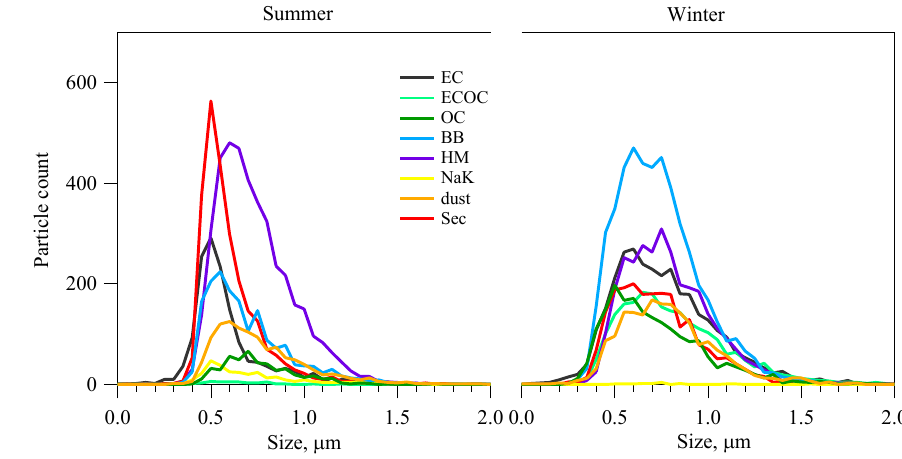
Figure 4. Unscaled size-resolved number distributions of major types of oxalic acid particles in summer and winter.